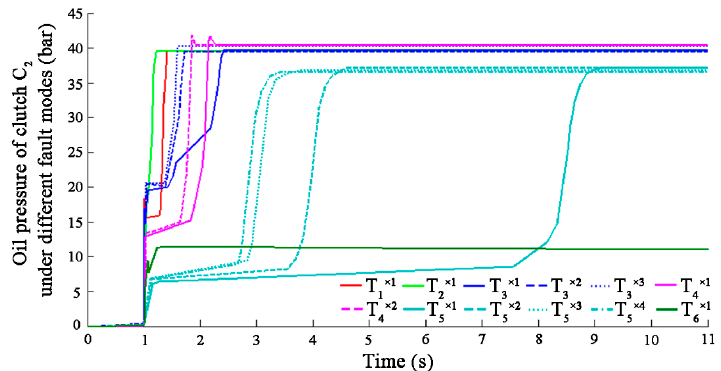
ff erent failure modes. 2 in di